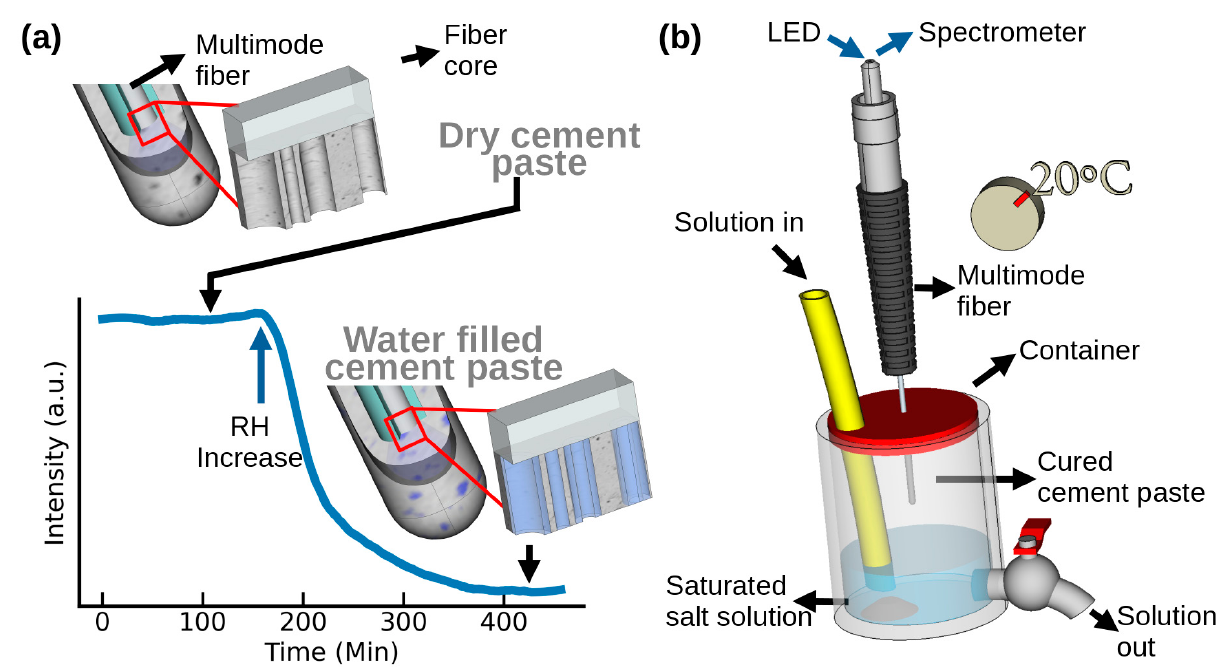
heavily dependent on the quantity of water occupying the cement pores, Figure 2a. The refractive index (RI) of the pores changed between 1 and 1.33 depending on the amount of water that filled the pores [22]. A change in RI influenced light reflectance at the tip, with it being higher if the pores were dry and lower if the pores were filled with water.